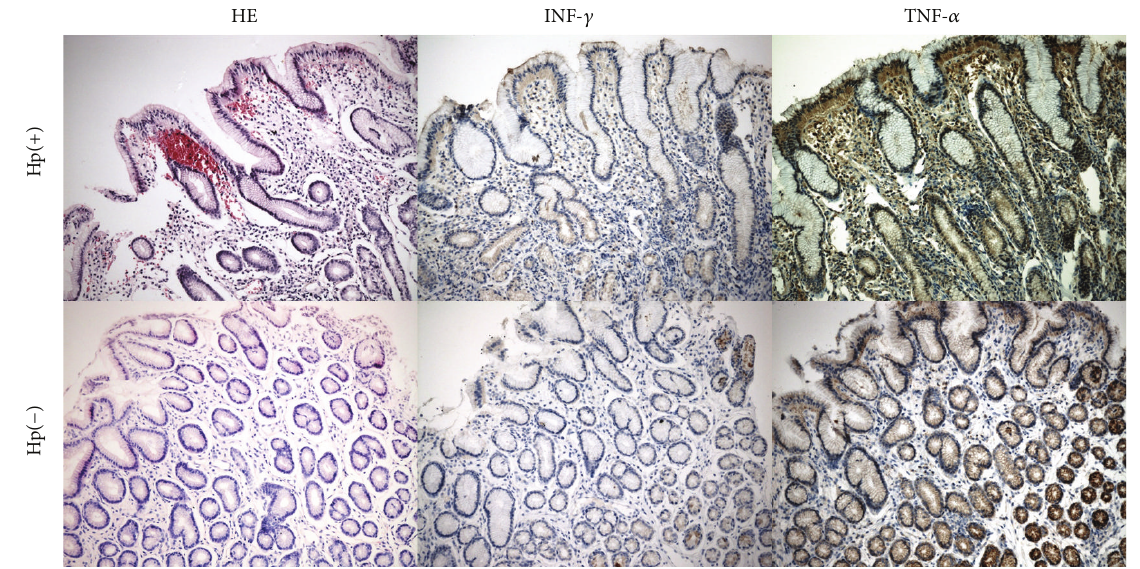
Figure1:Hematoxylin-eosin(HE)stainingandimmunohistochemicalstainingwithanti-IFN- 𝛾 andanti-TNF- 𝛼 in H.pylori infected(Hp(+)) and noninfected children (Hp( − )). Magnification, ×